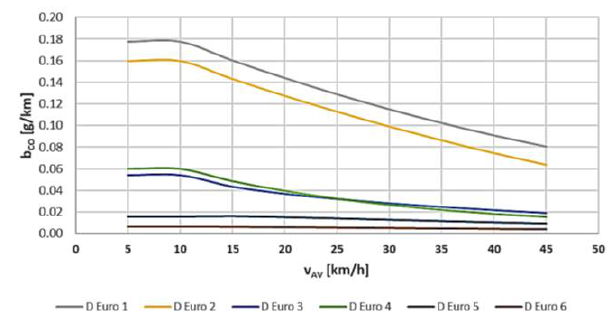
Fig. 27. NMVOC emission from CNG PCs for vehicle segments depending on average speed